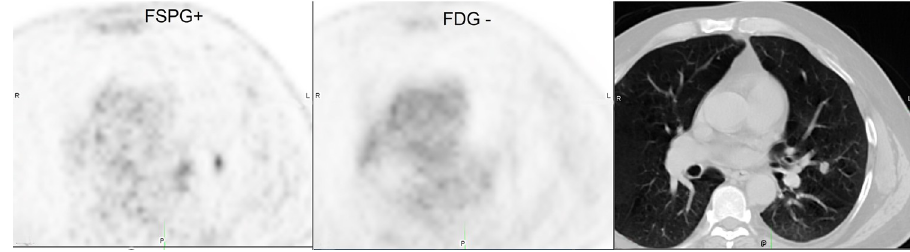
Fig 6. Subject with positive 18 F-FSPG (SUVmax 2.02) and negative 18 F-FDG (SUVmax 0.7) PET/CT.